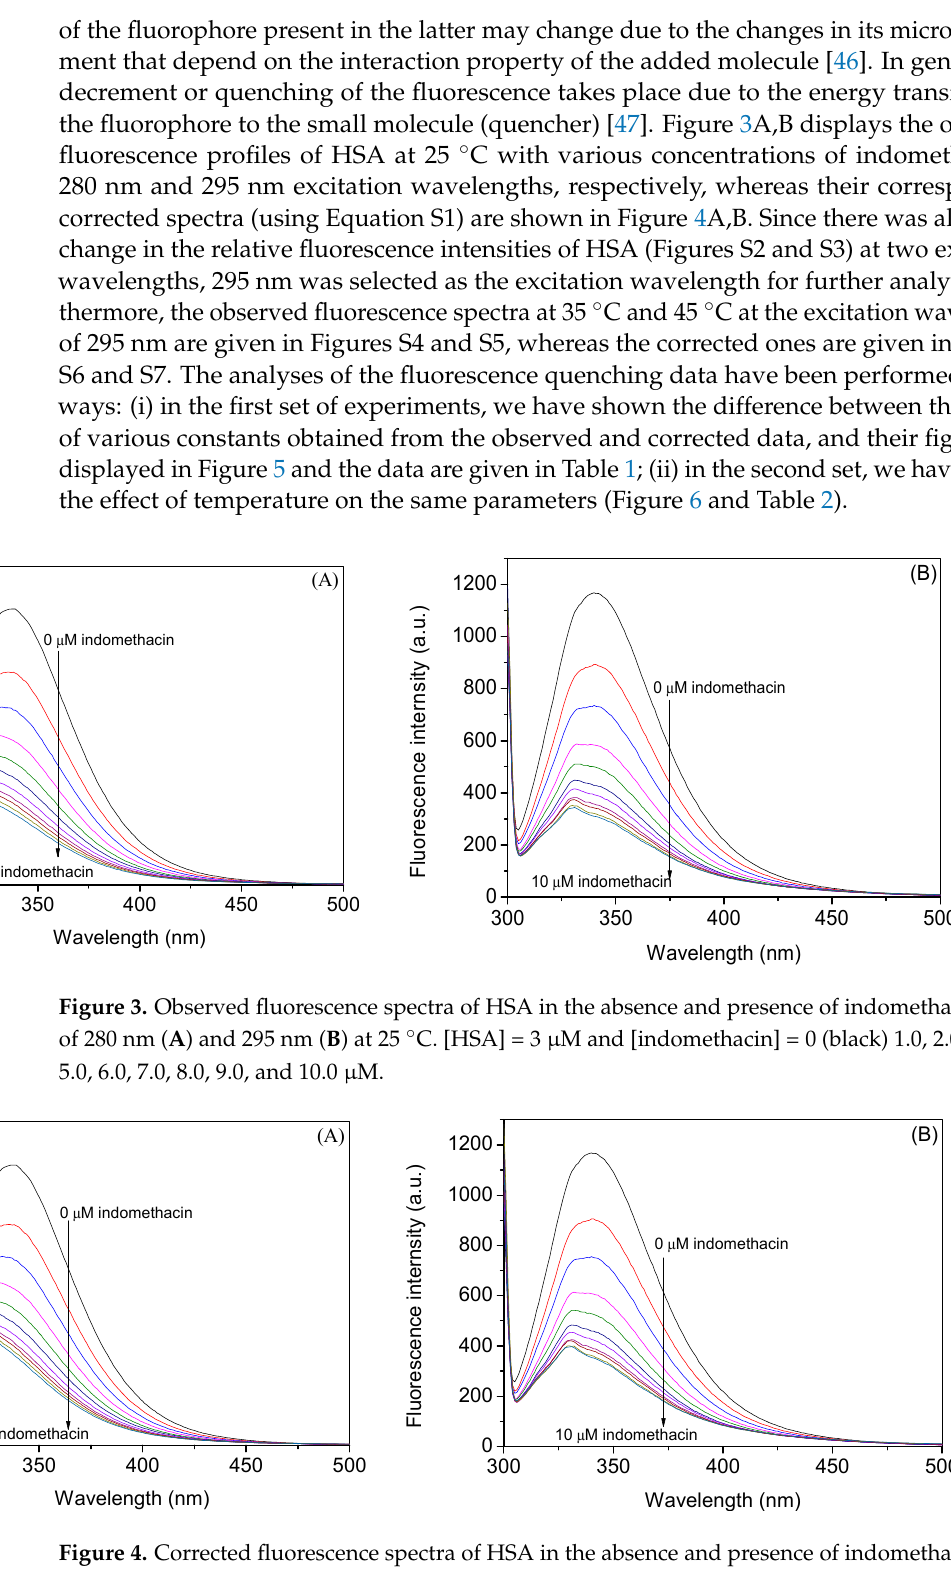
Figure 5. ( A ) Stern–Volmer plots of HSA–indomethacin interaction and ( B ) plots of log (F 0 –F)/F ver- sus log [indomethacin] at the excitation wavelength of 295 nm for the observed and corrected data. Figure 6. ( A ) Stern–Volmer plots of HSA-indomethacin interaction and ( B ) Plots of log (F 0 –F)/F ver- sus log [indomethacin] at the excitation wavelength of 295 nm at various temperatures.